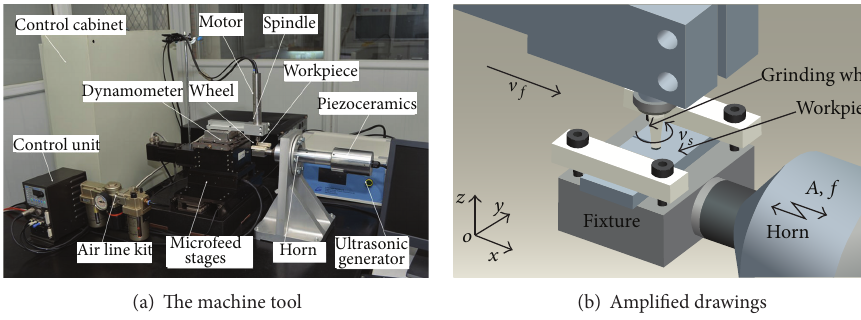
Figure 7: Experimental set-up.